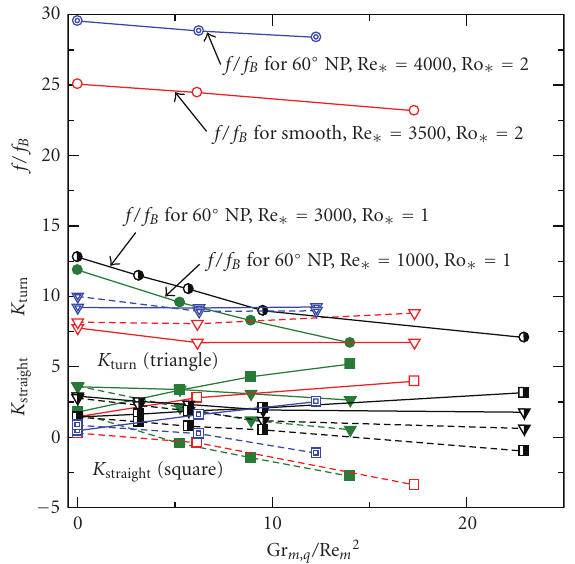
Figure 11: Buoyancy e ff ect on pressure loss (Legend for the symbols are the same as that in Figure 9. Symbols for K turn and K straight with solid lines are for turn A or first straight pass, and those with broken lines are for turn B or second straight pass).